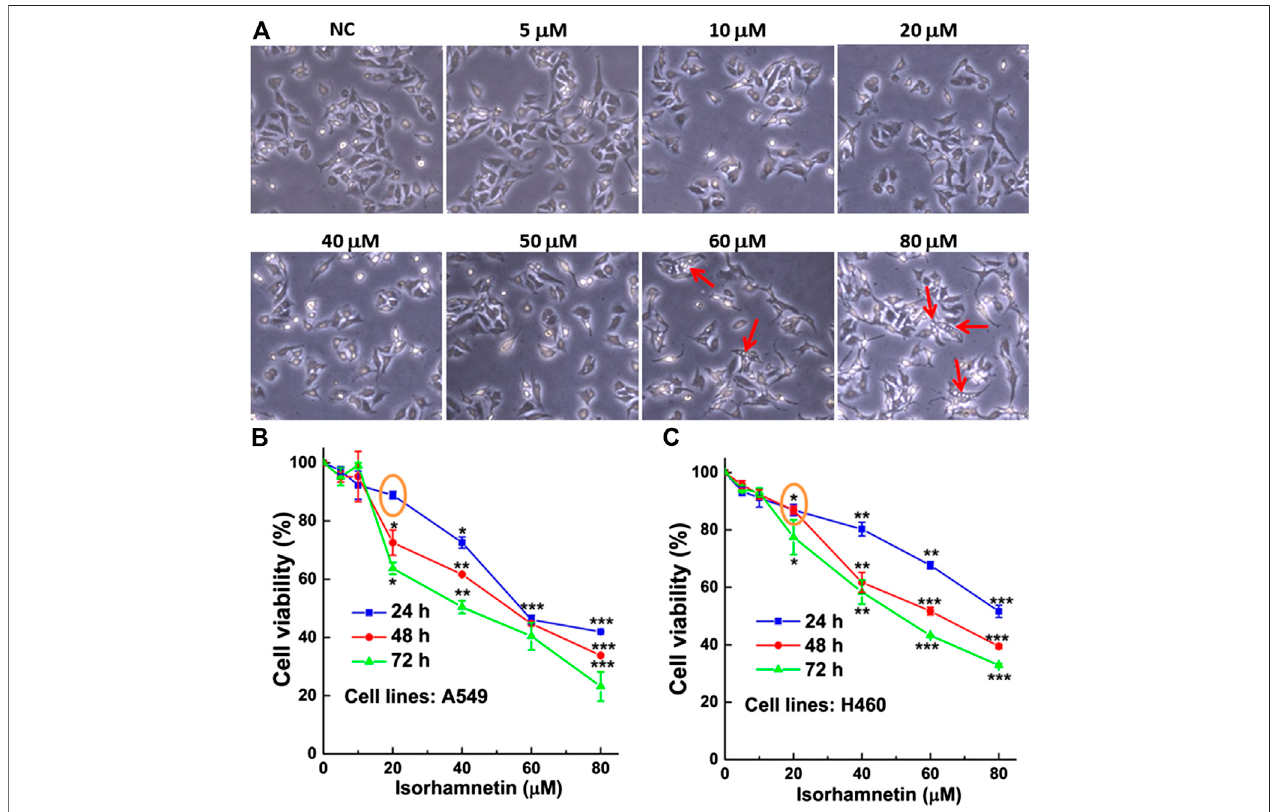
FIGURE 1 | ISO treatment induces vacuolation of NSCLC cells and inhibits cell proliferation. (A) The morphology of A549 cells after treatment with different concentrations(0, 5,10,20,40, 50,60,and80 μ M)ofISOfor24 h.Thered arrow indicates thevacuolated A549cells. Theinhibitory effectofISOwasdetected byMTT assay after different time of ISO treatment on the proliferations of A549 (B) and H460 (C) cell lines. * p < 0.05, ** p < 0.01, *** p < 0.001 vs. the control groups.